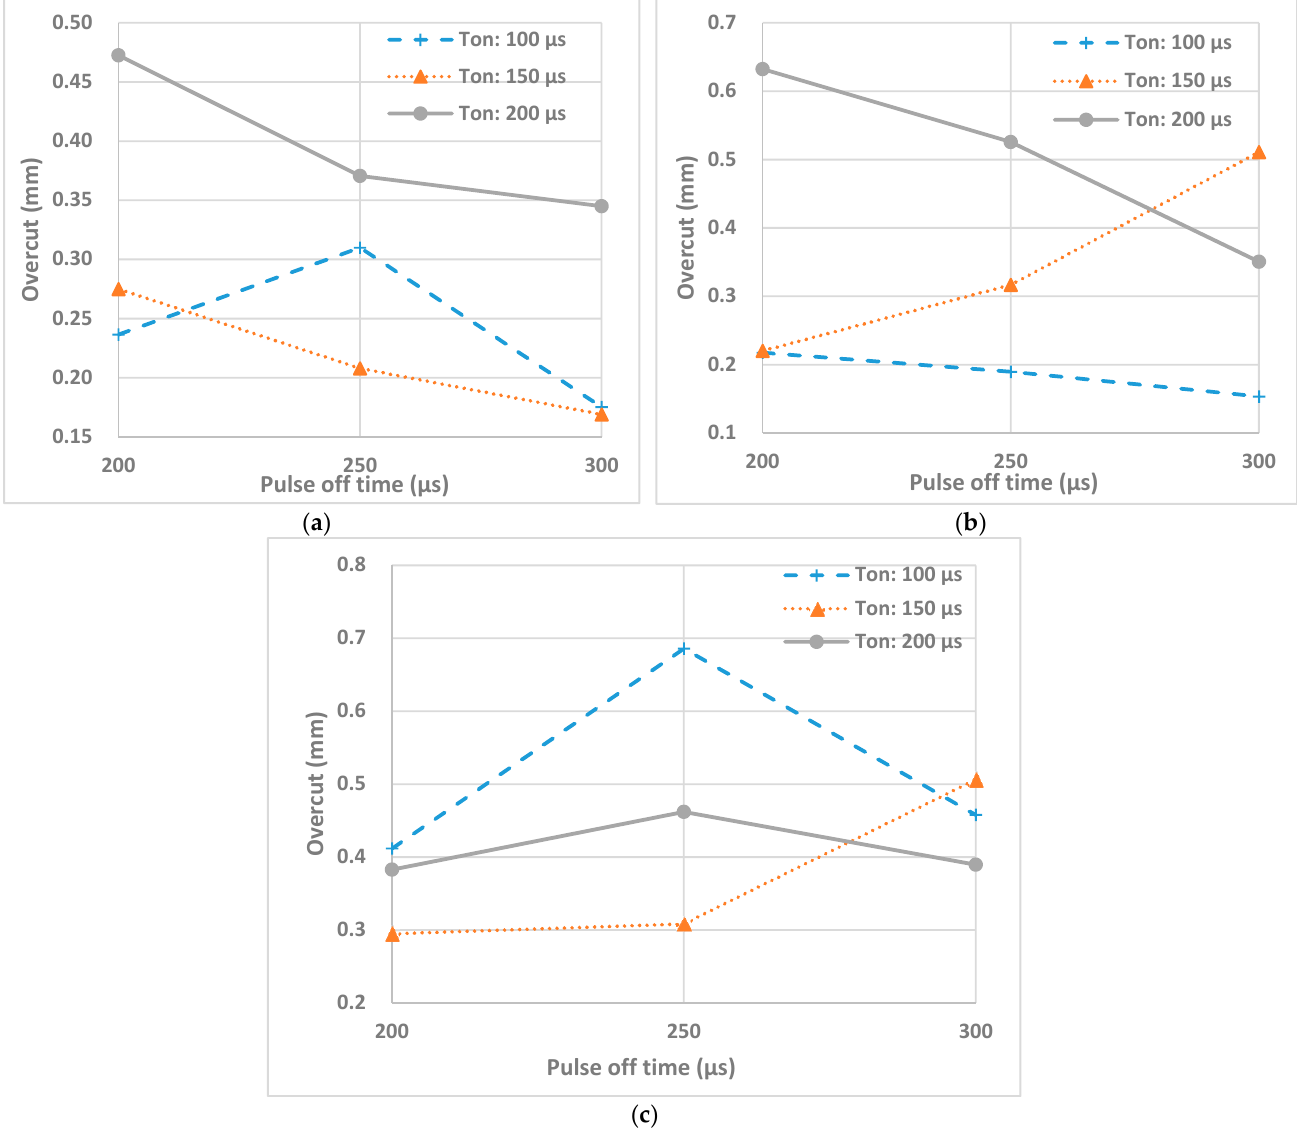
Figure 9. Effects of T on and T off on overcut at peak currents ( a ) 1 A, ( b ) 3 A, ( c ) 5A. The interaction effects and main effects of process parameters of EDM of nonconduc- tive ATZ on overcut were studied by conducting variance analysis by plotting these effects. In the Figure 10a the main effect plot for the overcut can be observed. For each parameter level, the means of overcut can be seen on this plot. Based on this plot, increasing the peak current raised the overcut. The increase in current resulted in the increase of MRR which in turn resulted in the increase of overcut. The effect of pulse on time on the overcut is not significant until 150 µ s but is found to increase at 200 µ s. The overcut increased slightly then decreased with the increase of pulse interval, as can be seen from Figure 10a.